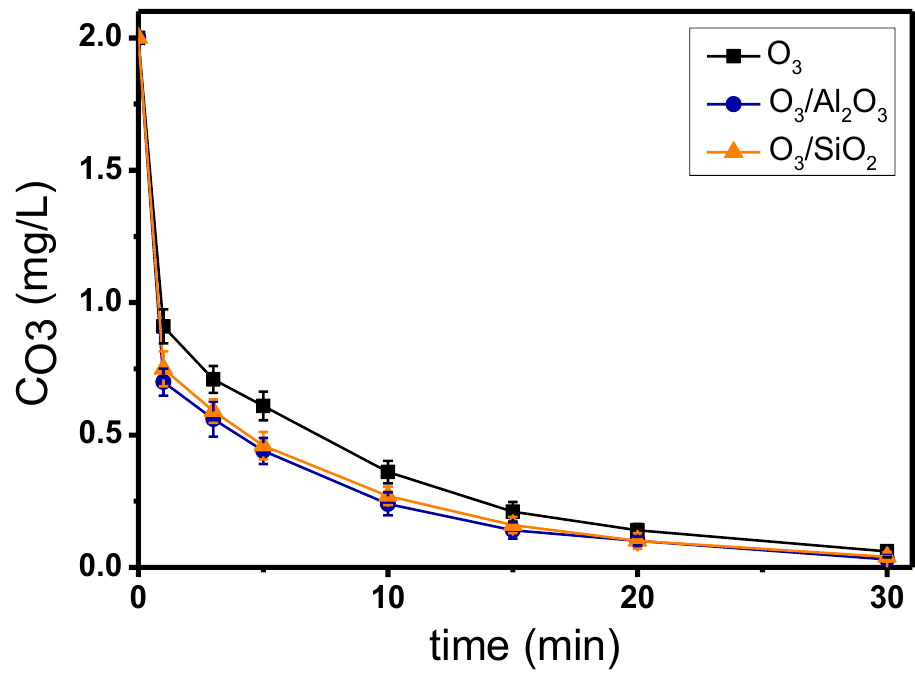
Figure 5. Ozone decomposition during catalytic ozonation of the mixture of the 8 examined micropollutants with the use of Al 2 O 3 and SiO 2 as catalysts compared to single ozonation in natural potable water. Experimental conditions: C MP. 50 μg/L, C cat. 0.5 g/L, C O3 2 mg/L, pH 7.8, T 23 ± 2 °C. Figure 6 shows the removal of each micropollutant separately in the mixed system during the application of single or catalytic ozonation experiments. The red dashed line represents the detection limit of the respective analytical technique for each micropollutant. In most cases, the reduction of initial concentration of micropollutants increased their removal rates, and as a result, the residual concentrations of all examined micropollutants in the mixture were found to be below the respective analytical detection